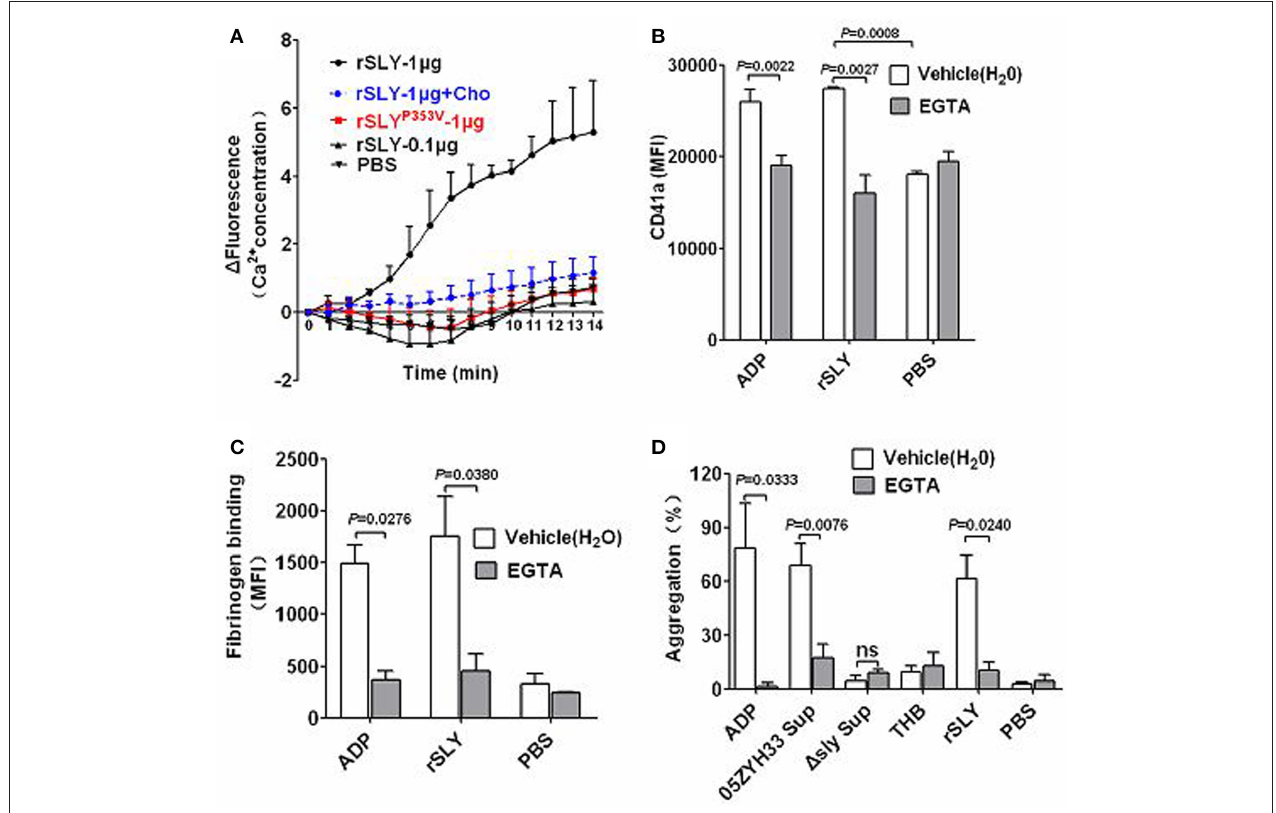
FIGURE 4 | Pore dependent Ca 2 + influx by SLY triggers platelet activation and aggregation. (A) rSLY induces Ca 2 + influx in human platelets. The purified platelets marked with fluo-8 were resuspended in HBSS (with 2 mM Ca 2 + ), and rSLY (1 µ g/ml), rSLY (0.1 µ g/ml), rSLY P353V (1 µ g/ml), cholesterol (10 µ g/ml), or other control reagents were added. Ca 2 + influx to platelets was detected using a Varioskan Flash Multiplate Reader. (B,C) The EGTA effect on rSLY-induced surface GPIIb/IIIa (CD41a) increase and fibrinogen binding to platelets in human blood was assessed by flow cytometry (Methods Section). Human blood was preincubated with EGTA (3 mM) for 10 min prior to addition of rSLY (1 µ g/ml). Unpaired two-tailed Student’s t -test was used for (B) statistical analysis. (D) The EGTA (3 mM) effect on S. suis supernatant-induced platelet aggregation was detected using a platelet aggregometer (Methods Section). Unpaired t -test with Welch’s correction was used for (C , D) statistical analysis. THB and PBS were the negative controls for culture supernatant and proteins, respectively. EGTA was dissolved in H 2 O. Data in panels (A–D) are expressed as the mean ± SD of three independent experiments, with each experiment using blood from a different donor. P < 0.05 is considered to be